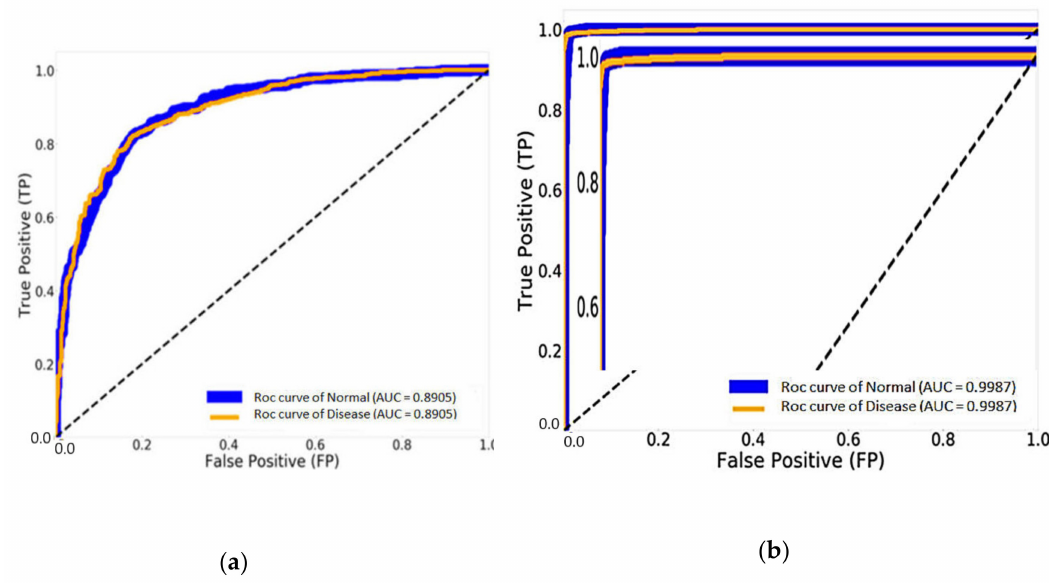
Figure 14. The results of the area under the curve (AUC) and receiver operating characteristics (ROC) curve: ( a ) DenseNet-121 and ( b ) DenseNet-121 combined with Mish and